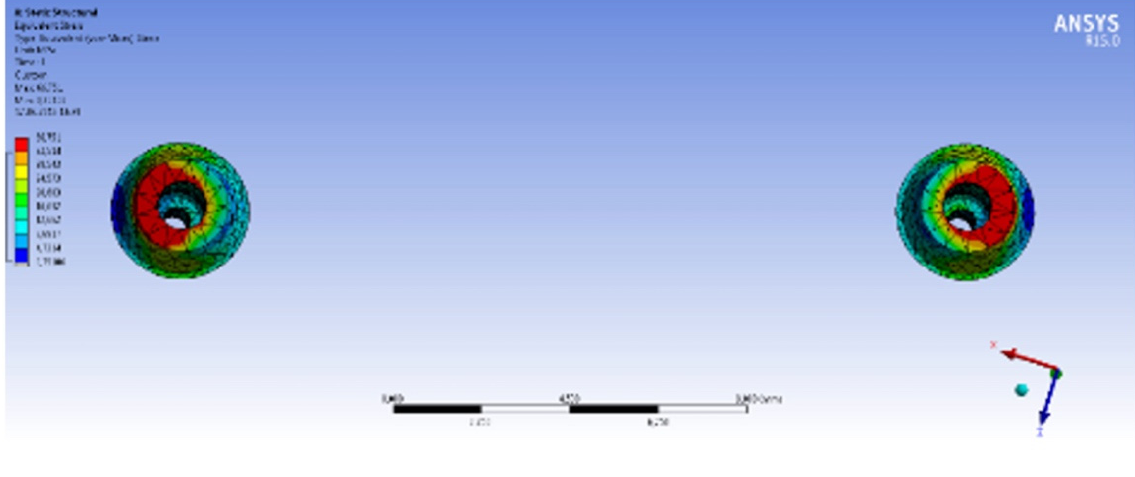
Figure 7. Model 1 implants and the Von Mises stress distribution after oblique loading.